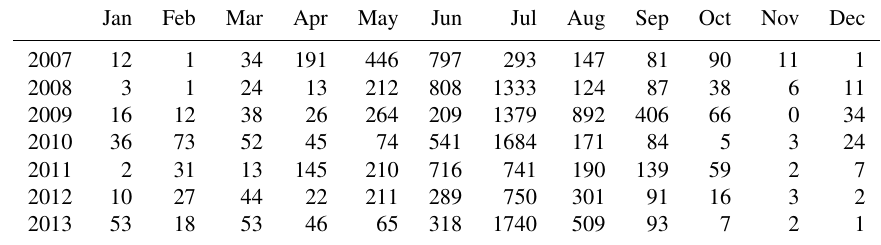
Table 2. Number of complete hourly non-rainy daytime radar echoes at the 12 selected radar stations. Jan Feb Mar Apr May